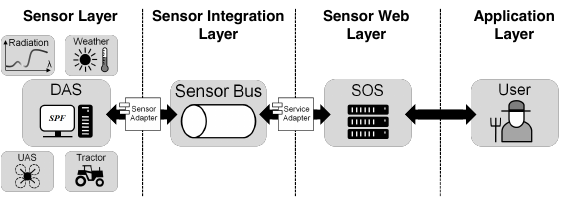
Figure 6. SWE infrastructure for precision farming (Geipel) Figure 1. The extended sensor infrastructure stack as introduced by Bröring et al. [18]. It is based on three main layers for: (i) sensor control and communication (sensor layer); (ii)SensorWebEnablement(SWE)servicesaspartofasensorweb(sensorweblayer);and (iii)endusersandcomputers(applicationlayer),whichbuildapplicationsontopoftheSWE services. A fourth layer is an intermediary integration layer, facilitating the connection of sensorsandservices(sensorintegrationlayer).